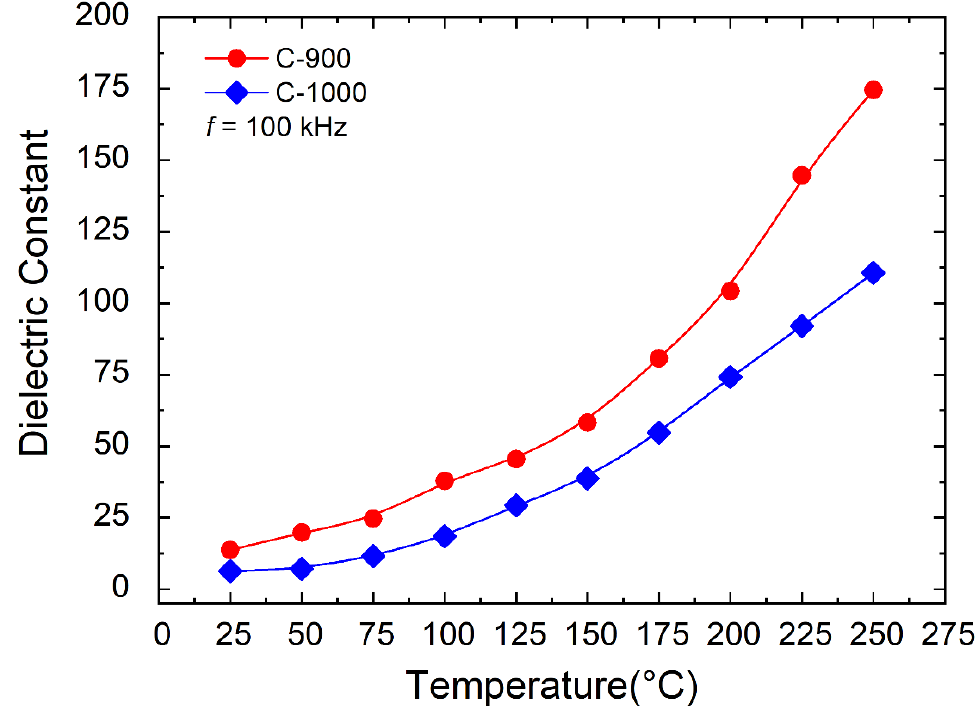
Figure 7. The temperature-dependent dielectric constant of frequency for C-900 and C-1000 ceram- ics.